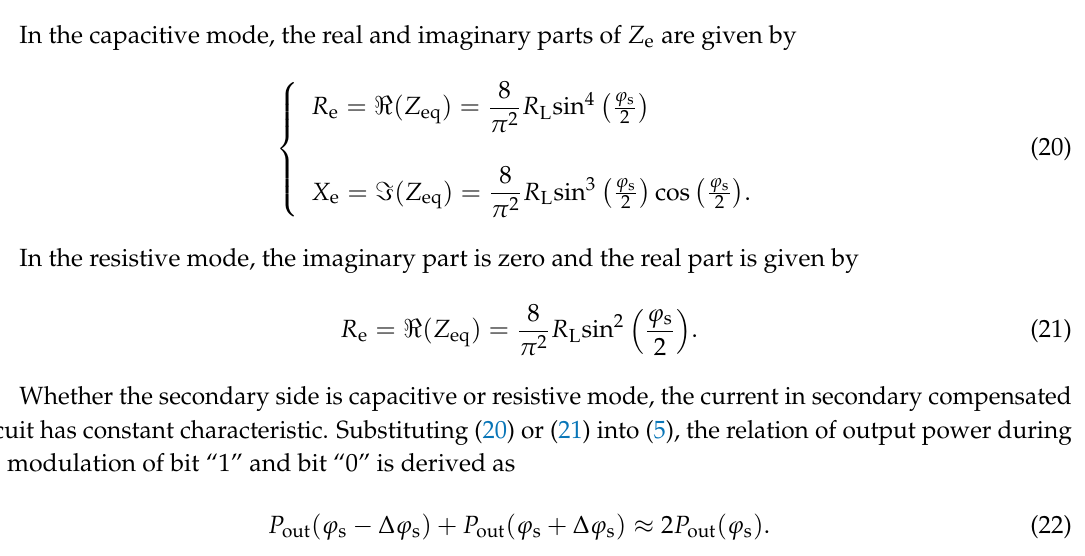
Figure 9. Key waveforms of the S-BAR and modulator during the modulation of bit “1” and bit